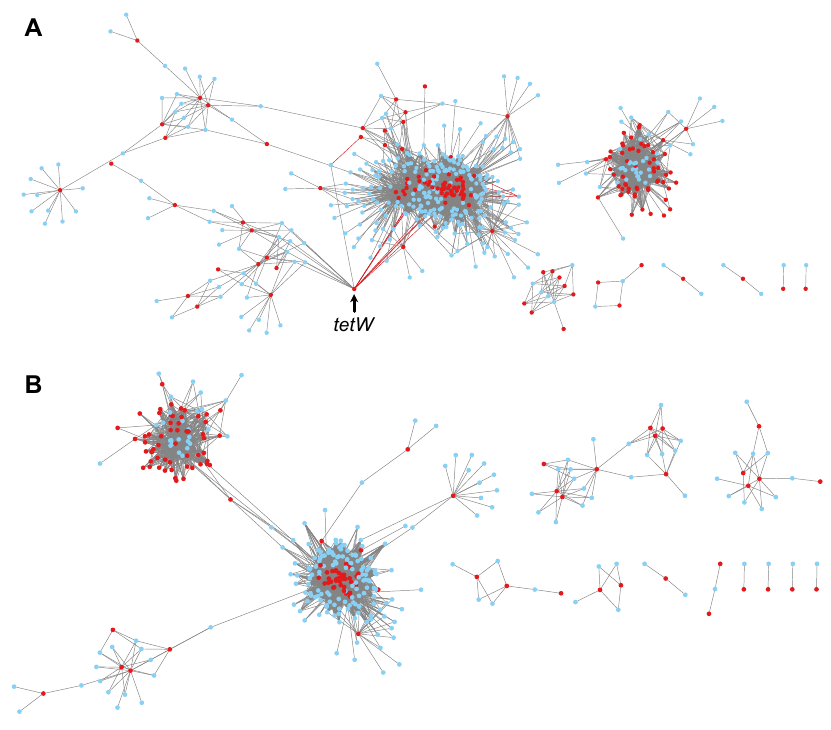
Figure 7. Correlations between ARGs (red circles) and ISs (blue circles) for data from dairy cows ( A ) and feedlot cattle ( B ). For dairy cows, the red links indicate the negative correlations with the tetW gene (shown by the